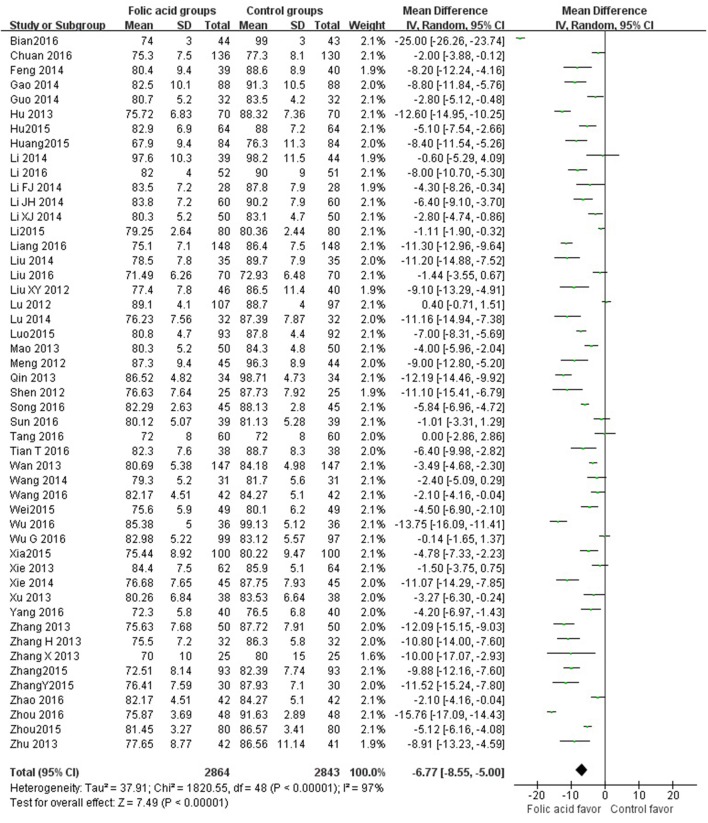
Forest Plot of effect sizes for DBP; DBP: Diastolic Blood Pressure.